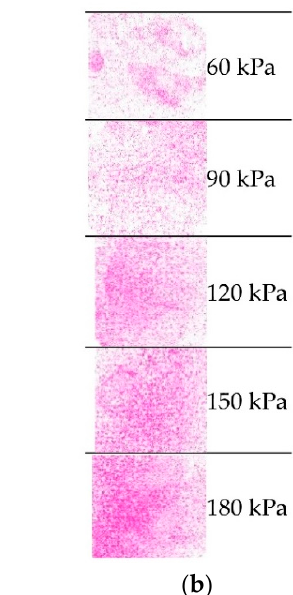
Figure 20. Pressure in the soil obtained from the test P5.R.CFS: ( a ) pressure map of horizontal stresses; ( b ) pressure scale.